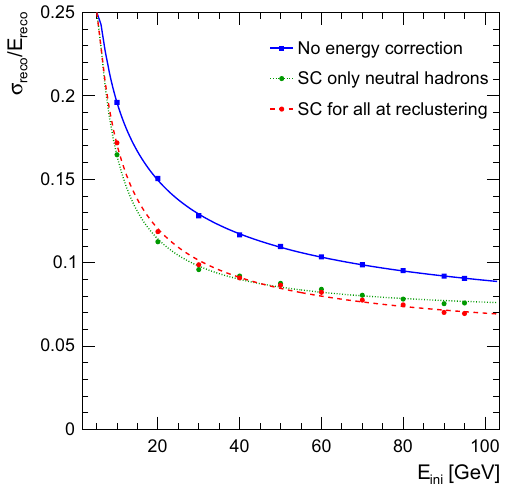
Fig. 6 Single particle energy resolution without energy correction (blue), when applying SC for neutral cluster at PFO level (green) and when applying SC at the reclustering step for all clusters (red)